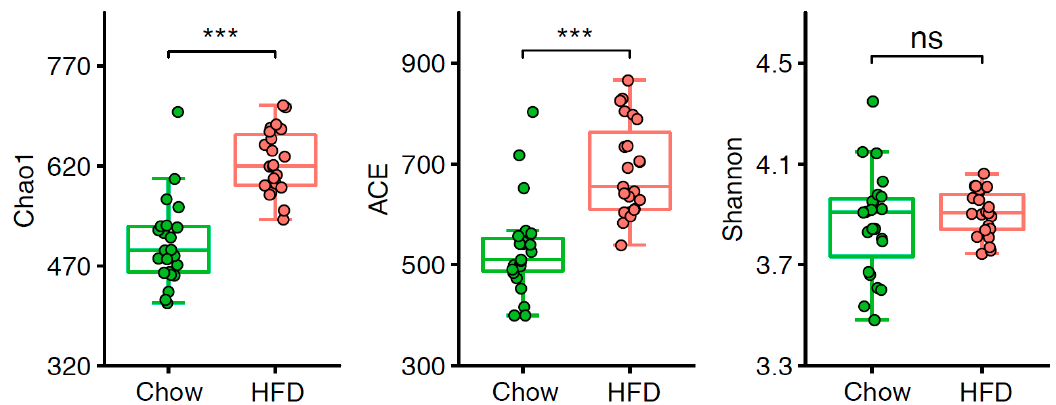
Figure 2. Alpha-diversity of the gut microbiota in two groups. Chao1, ACE, and Shannon indices were compared between chow-fed ( n = 23) and HFD-fed ( n = 23) T2D mice. *** p < 0.001, “ns” indicates no significance.